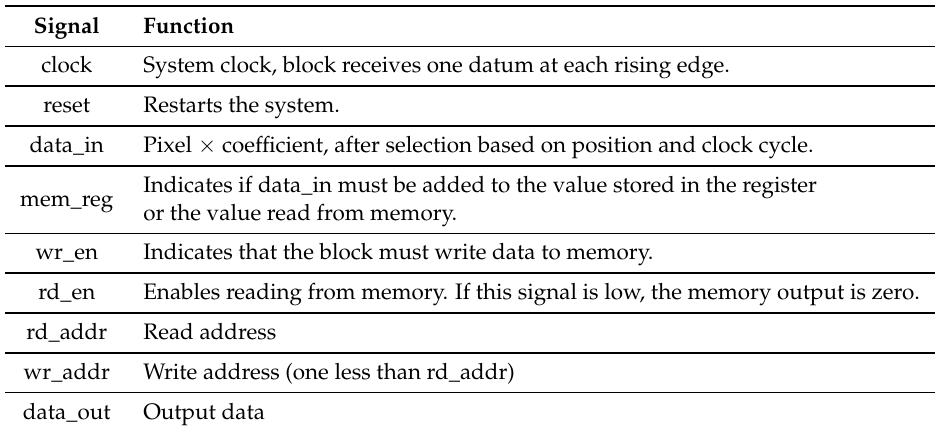
Figure 6. Block diagram of basic component. Table 3. Description of I/O signals of basic